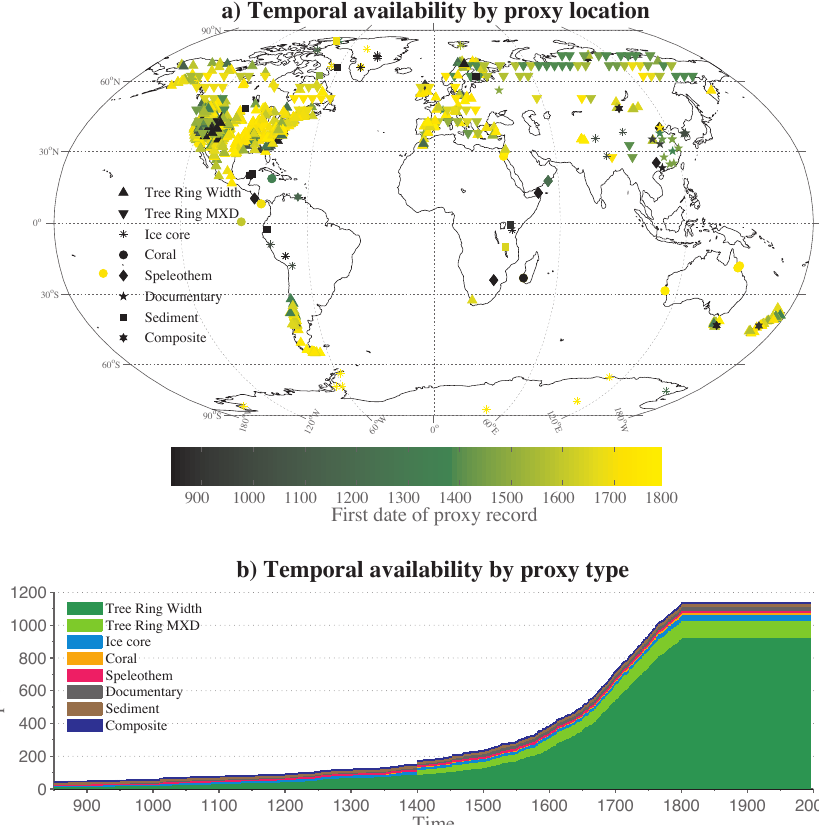
Fig. 1. Temporal and spatial availability of the M08 proxy network between 850–1800AD. Top panel: the spatial distribution of the M08 proxies, with colored dots indicating the first year that each proxy record becomes available. Each marker represents a proxy class, as indicated in the legend. Bottom panel: the temporal availability of each proxy